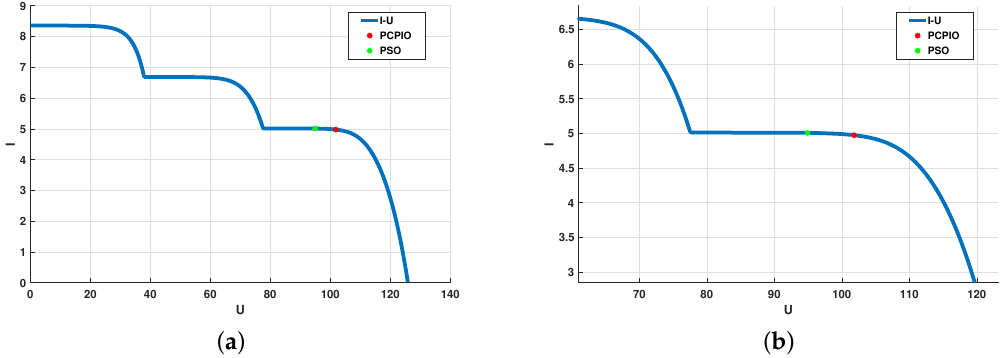
Figure 8. I–V curve of PV array under partial shadow and standard environment. ( a ): PV array under standard environment ( b ): PV array under shadow